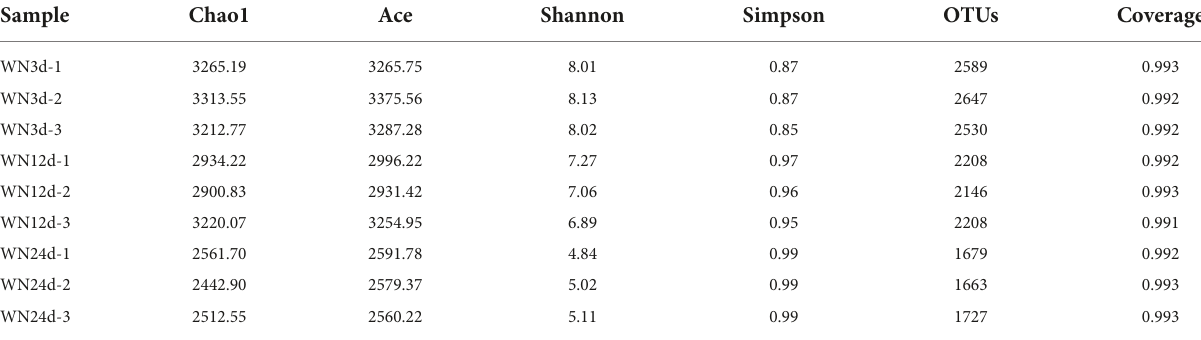
TABLE 3 The alpha diversity of microbial communities in compost samples.